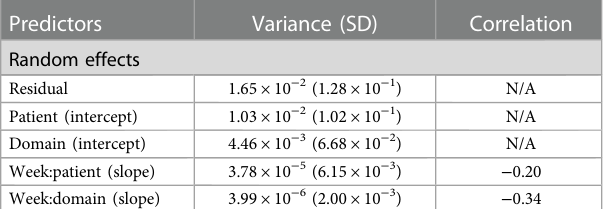
TABLE 3 Final linear mixed-effects model results summary of consistent cohort (random